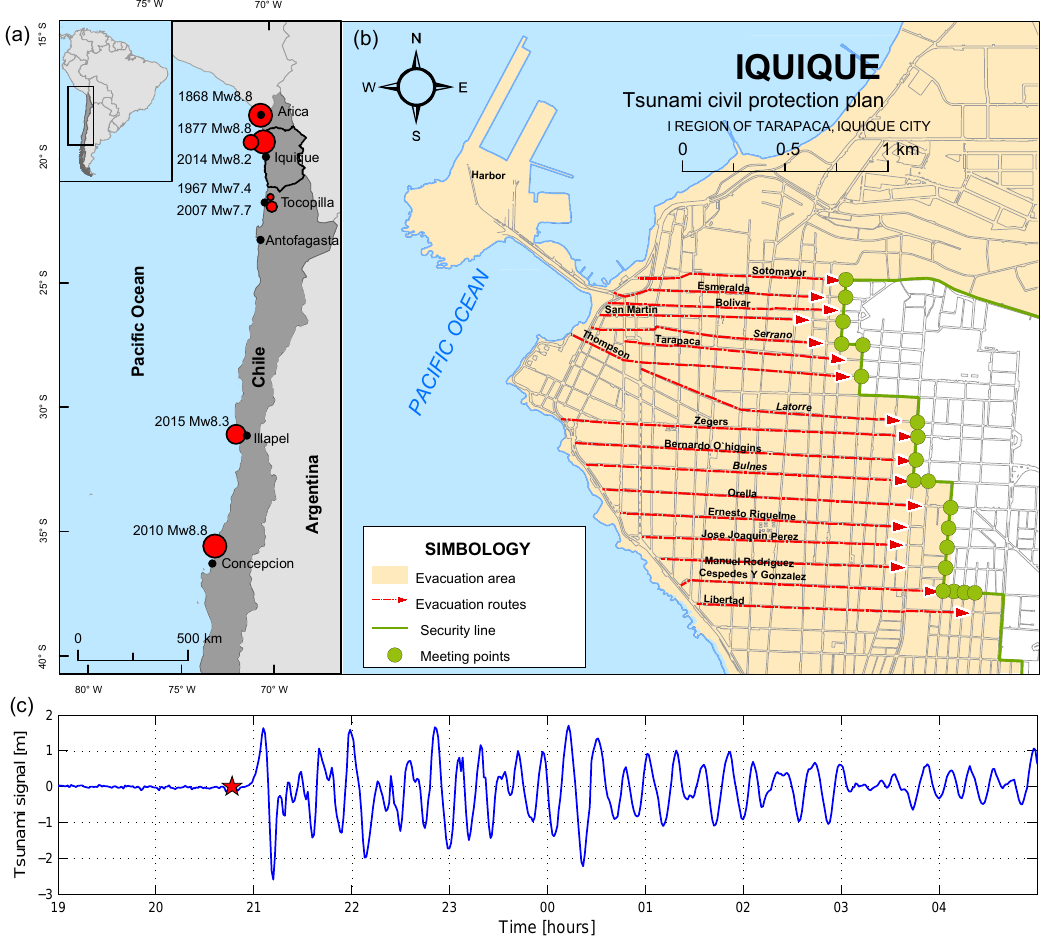
Figure 1. (a) Geographical location of the study area and a selection of major earthquakes (red circles) that have affected north-central Chile since 1868 (epicenters based on the records of the National Seismological Center of the University of Chile and the United States Geological Survey). (b) Downtown Iquique and its tsunami evacuation routes (modified from ONEMI and IMI, 2013). (c) The Iquique tide gauge tsunami signal for the 2014 event; the red star indicates the moment of earthquake